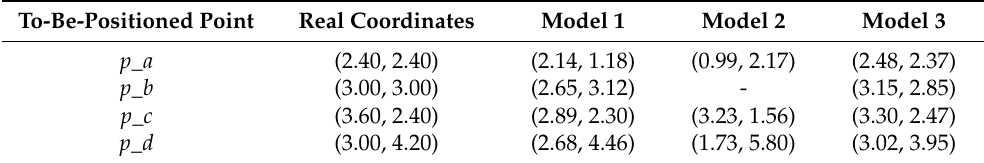
Table 10. The estimated coordinates of the three models